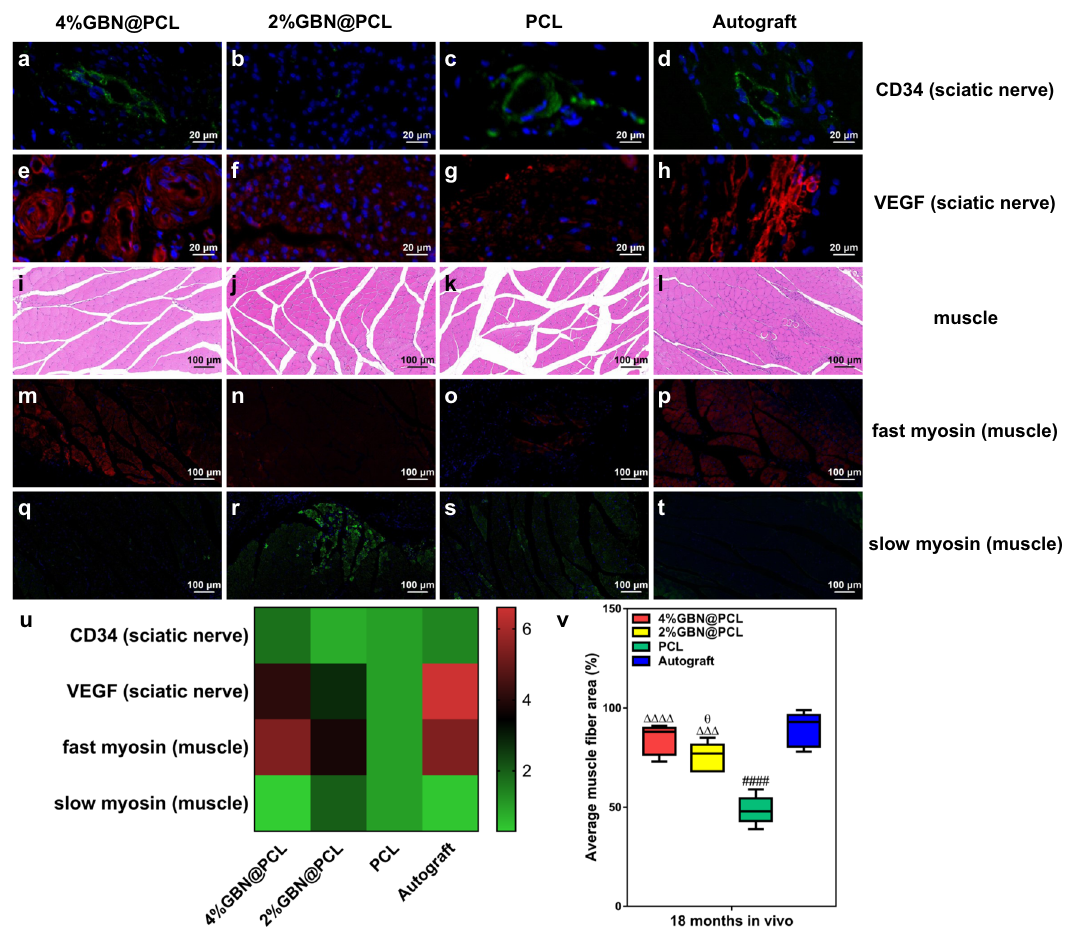
Fig. 4 Angiogenesis in the peripheral nerves and muscle atrophy alleviation by GBN. CD34 ( a – d ) and VEGF ( e – h ) immunostaining of the regenerated sciatic nerve sections. Morphology of the gastrocnemius muscle using HE staining ( i – l ). Green fl uorescence, CD34; Red fl uorescence, VEGF; Blue fl uorescence, nuclei. Fast myosin ( m – p ) and slow myosin ( q – t ) immunostaining of the gastrocnemius muscle. Red fl uorescence, fast myosin; Green fl uorescence, slow myosin; Blue fl uorescence, nuclei. Relative expression levels of CD34 and VEGF of the sciatic nerves, and fast myosin and slow myosin of the muscles ( u ). Average muscle fi ber area (%) ( v ). ΔΔΔ represents p < 0.001, ΔΔΔΔ represents p < 0.0001 in comparison with PCL; #### represents p < 0.0001 for PCL vs. autograft. θ represents p < 0.05 in comparison with autograft. The center line, bounds of box, and whiskers were displayed in the fi gures, respectively.